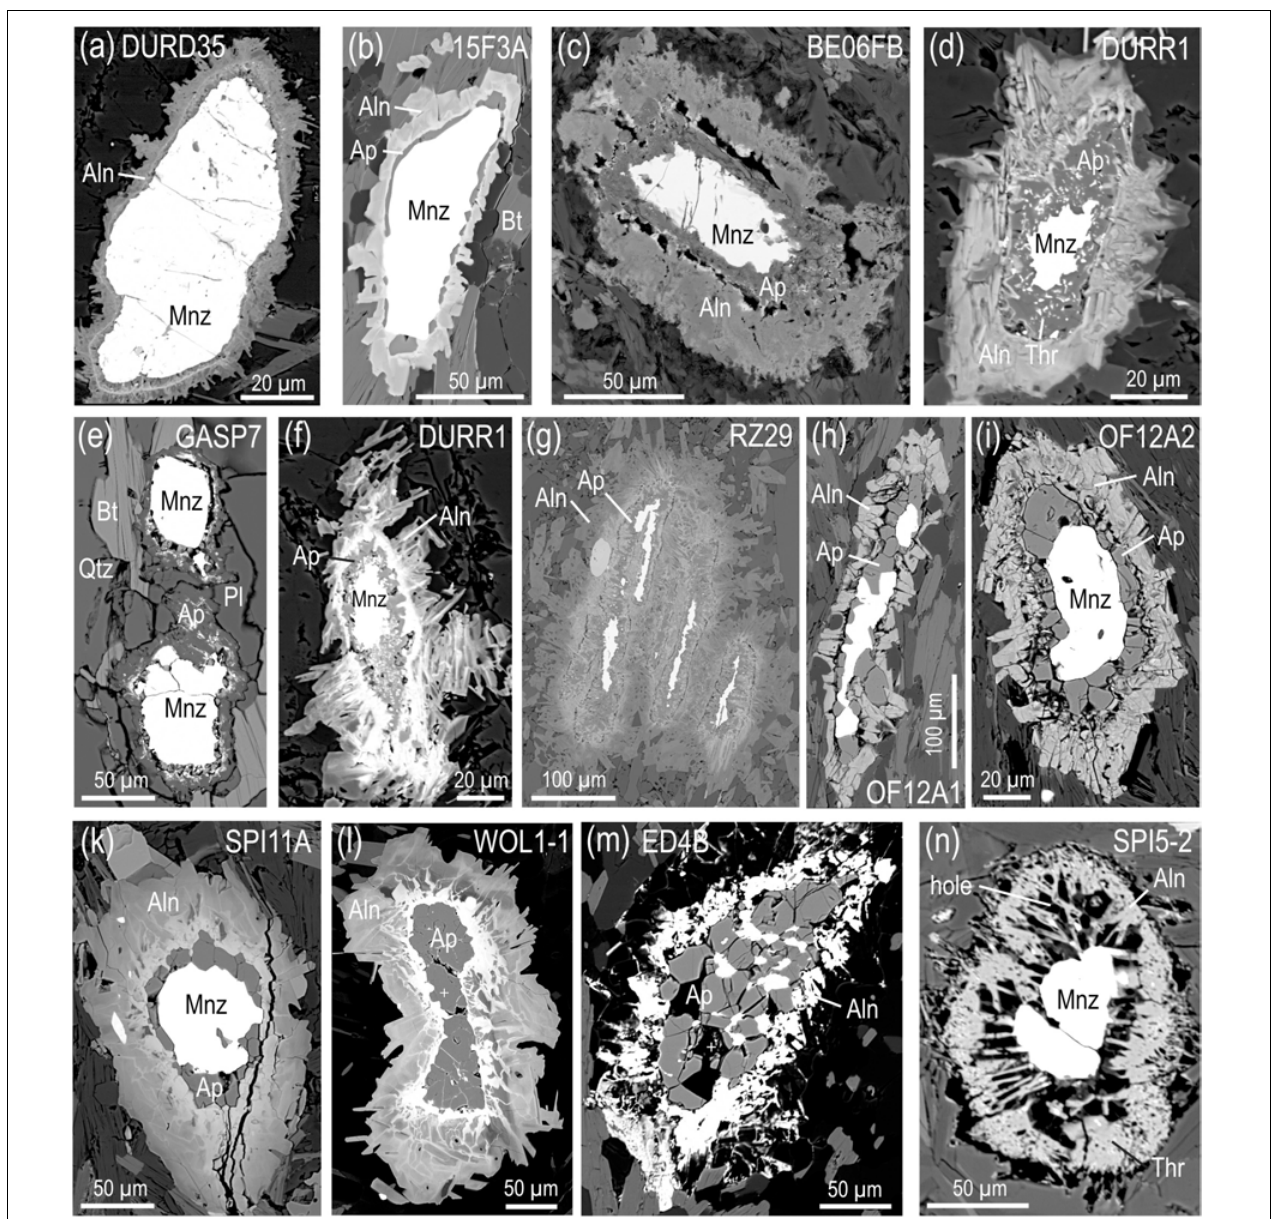
FIGURE 6 | Corona structures of monazite. (a) Rim with radial allanite (Aln) crystals mantling a monazite (Mnz), Austroalpine Oetztal-Stubai Basement (Rode et al., 2012). (b) Allanite mantle and monazite core are separated by a tiny zone with apatite (Ap). (c) Monazite in a phyllite with double corona of inner apatite and outer allanite. (d) Monazite core with sutured grain boundary is surrounded by a corona with apatite and tiny thorite (Thr), and a corona with prismatic allanite. (e) Monazite cores are surrounded by apatite and thorite. (f) Partly consumed monazite with sutured grain boundary is surrounded by apatite and allanite coronas. The inner part of the allanite corona is conspicious by Th-rich allanite. (g) Thin relict bands of monazite in apatite-allanite coronas. (h,i,k) Corona structures in a Saualpe micaschist. Apatite and allanite grains underwent static recrystallization due to a thermal overprint (Schulz, 2017). (l) Corona structure with fully consumed monazite in the apatite core with tiny thorite grains; see light Th-rich inner part of the allanite corona. (m) Apatite with corona by Th-rich allanite. (n) Allanite crystals with tiny thorite inclusions rim relict monazite in a Saualpe micaschist. The holes may have been water-soluble phospate